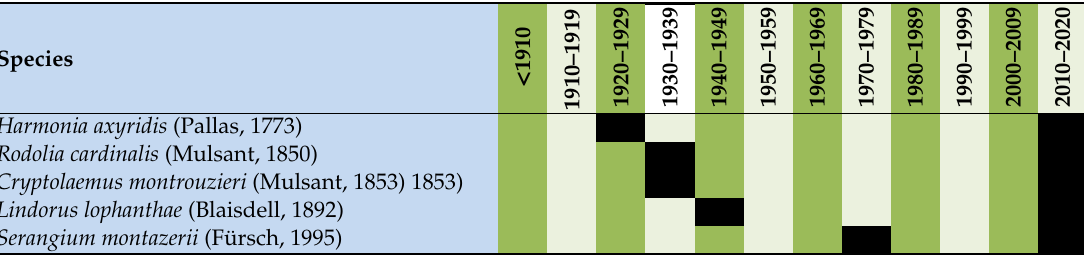
Table 3. The ladybird species intentionally released for pest control and established in the region. The decades when the releases of the species began are shaded with black and indicated with “i”. The decades when the species were detected by us are shaded with